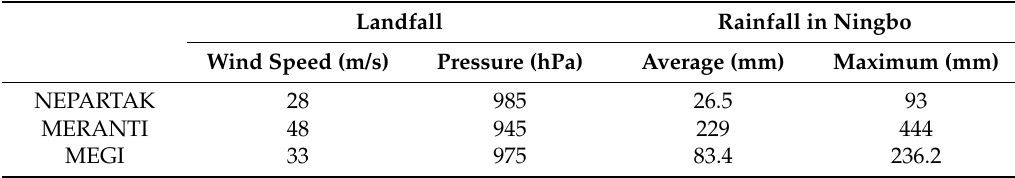
Table 1. NEPARTAK, MERANTI, and MEGI typhoons wind speed and pressure during landfall, and the average/maximum rainfall during the typhoon